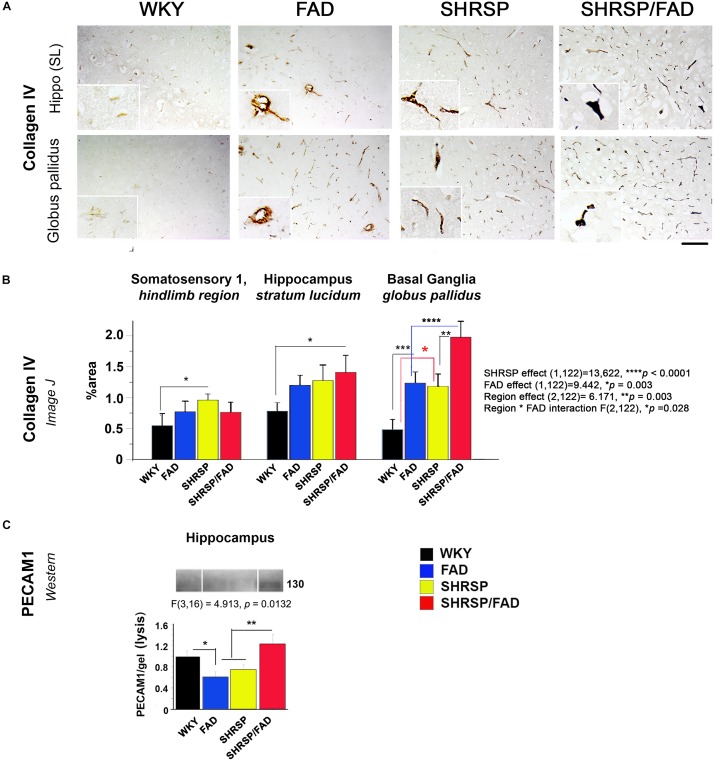
Collagen IV deposition is increased in FAD and SHRSP rats, while PECAM-1 is increased in SHRSP/FAD rats only. (A) Micrographs depict collagen IV staining in stratum lucidum of the hippocampus and globus pallidus of the basal ganglia. In all brain regions of WKY rats, vessels were lightly stained, and there was no staining in the vessel lumen. However, in SHRSP rats, the lumen of capillaries showed sparse collagen IV immunoreactivity. There was increased staining in the globus pallidus of FAD rats, which was exacerbated in SHRSP/FAD rats, in which vessel walls appeared distorted and thickened. (B) Two-way ANOVA was performed [region (three brain regions) × FAD (Tg+ or Tg–) × SHRSP (non-SHRSP or WKY)]. The main effects for both SHRSP were highly significant (p < 0.0001), and the effects for FAD, the effects of region and the interaction between FAD and region were also significant (p = 0.003, p = 0.003, and p = 0.028 respectively). Post hoc analysis with planned comparisons showed elevated intensity of collagen-IV staining in the hindlimb of SHRSP rats, compared to WKY (p < 0.05). In stratum lucidum of the hippocampus, collagen-IV staining was significantly elevated in SHRSP/FAD rats, compared to WKY (p < 0.05). Collagen-IV staining was increased significantly in the globus pallidus of FAD (p < 0.001) and SHRSP rats (p < 0.0001), compared to WKY. In SHRSP/FAD rats, collagen-IV staining was significantly increased further compared to FAD (p < 0.001) and SHRSP (p < 0.01) rats. (C) We also measured endothelial cell marker PECAM-1 in the lysis fraction of hippocampal tissue. Representative gel blots are shown and densitometry of bands was evaluated via one-way ANOVA, which demonstrated significant effects of strain on PECAM-1 levels. Post hoc analysis showed that levels of PECAM-1 were significantly elevated in the hippocampal lysis fraction from SHRSP/FAD rats, compared with FAD and SHRSP rats (p < 0.01). Levels of PECAM-1 were also significantly reduced in FAD rats, compared to WKY (p < 0.05). Data represent means ± SEM. ∗p < 0.05, ∗∗p < 0.01, ∗∗∗p < 0.001, ****p < 0.0001.